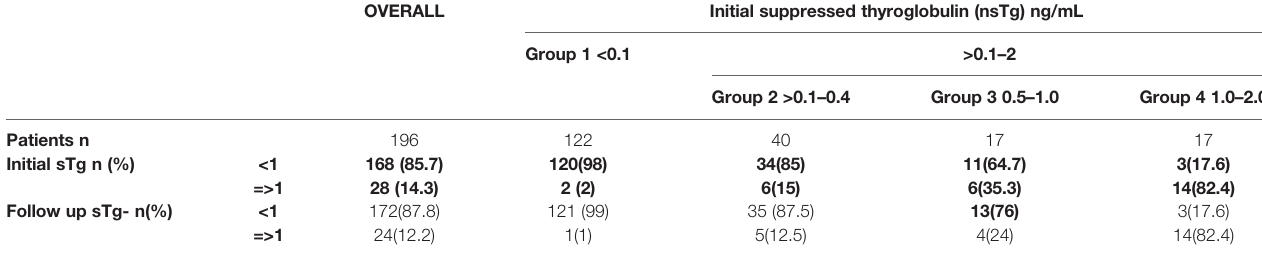
TABLE 2 | Initial and Follow-up Stimulated